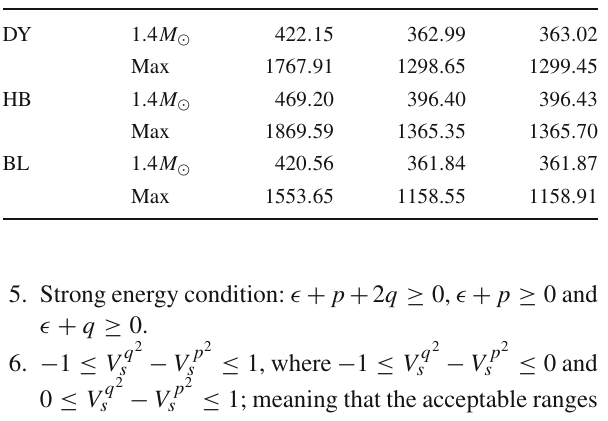
Table2 StrongenergyconditioninthecenterofanisotropicNSswhere the unit is MeV fm − 3 Model